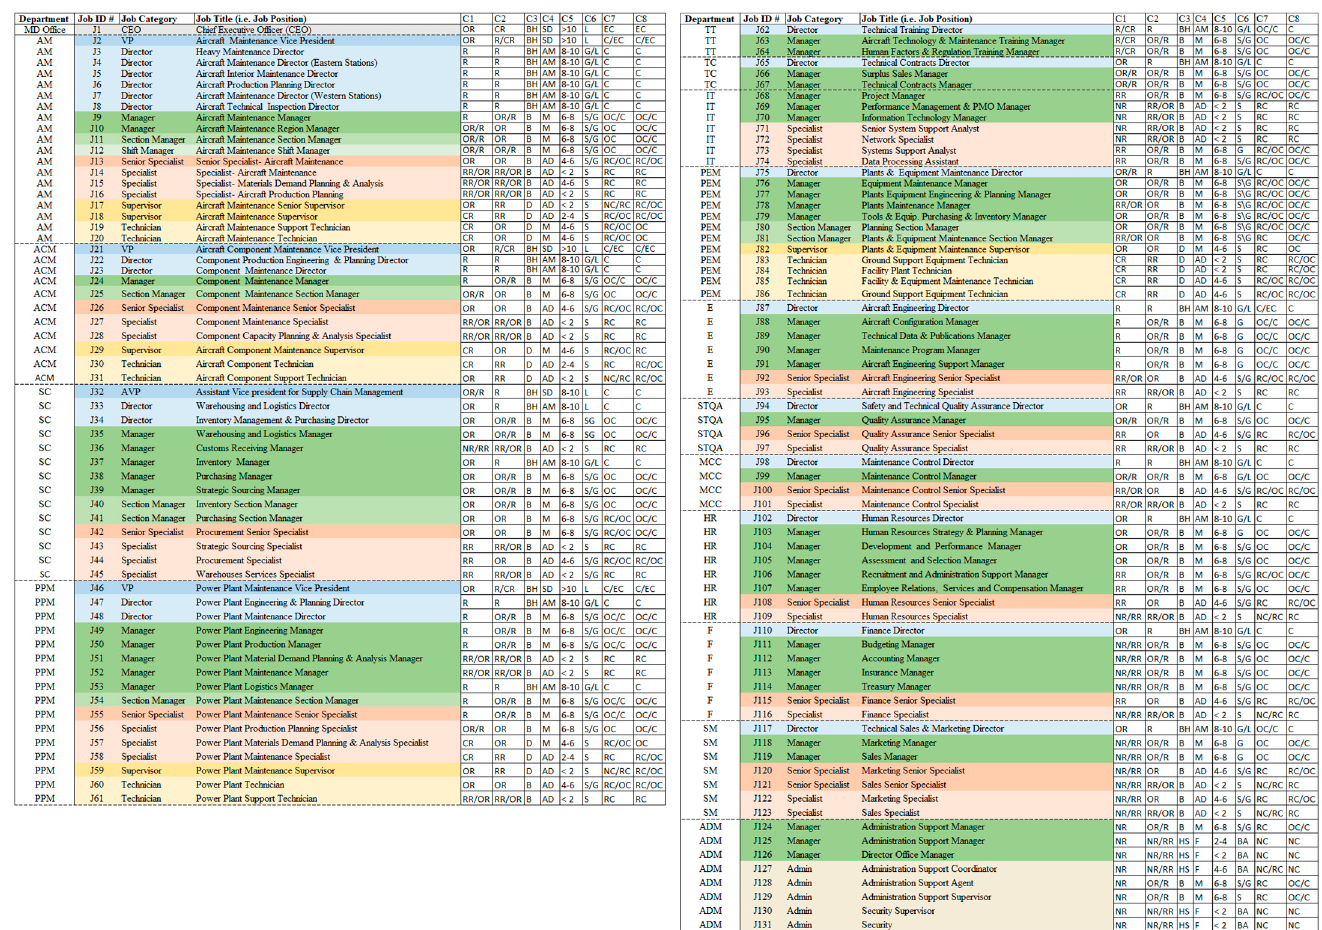
Figure 2. Rating of each job position with respect to each job evaluation criterion using linguistic terms.